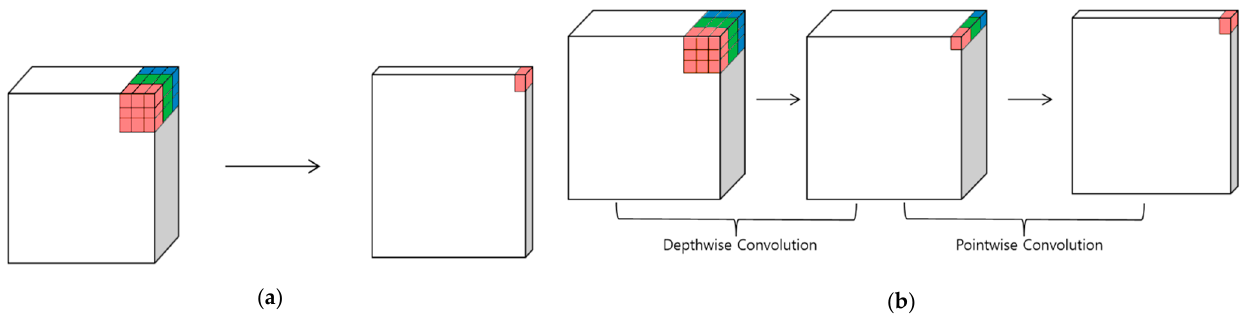
Figure 3. Extreme version of the inception module.